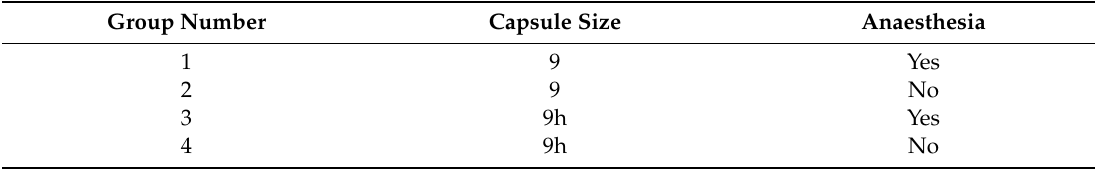
Table 2. Groups of study